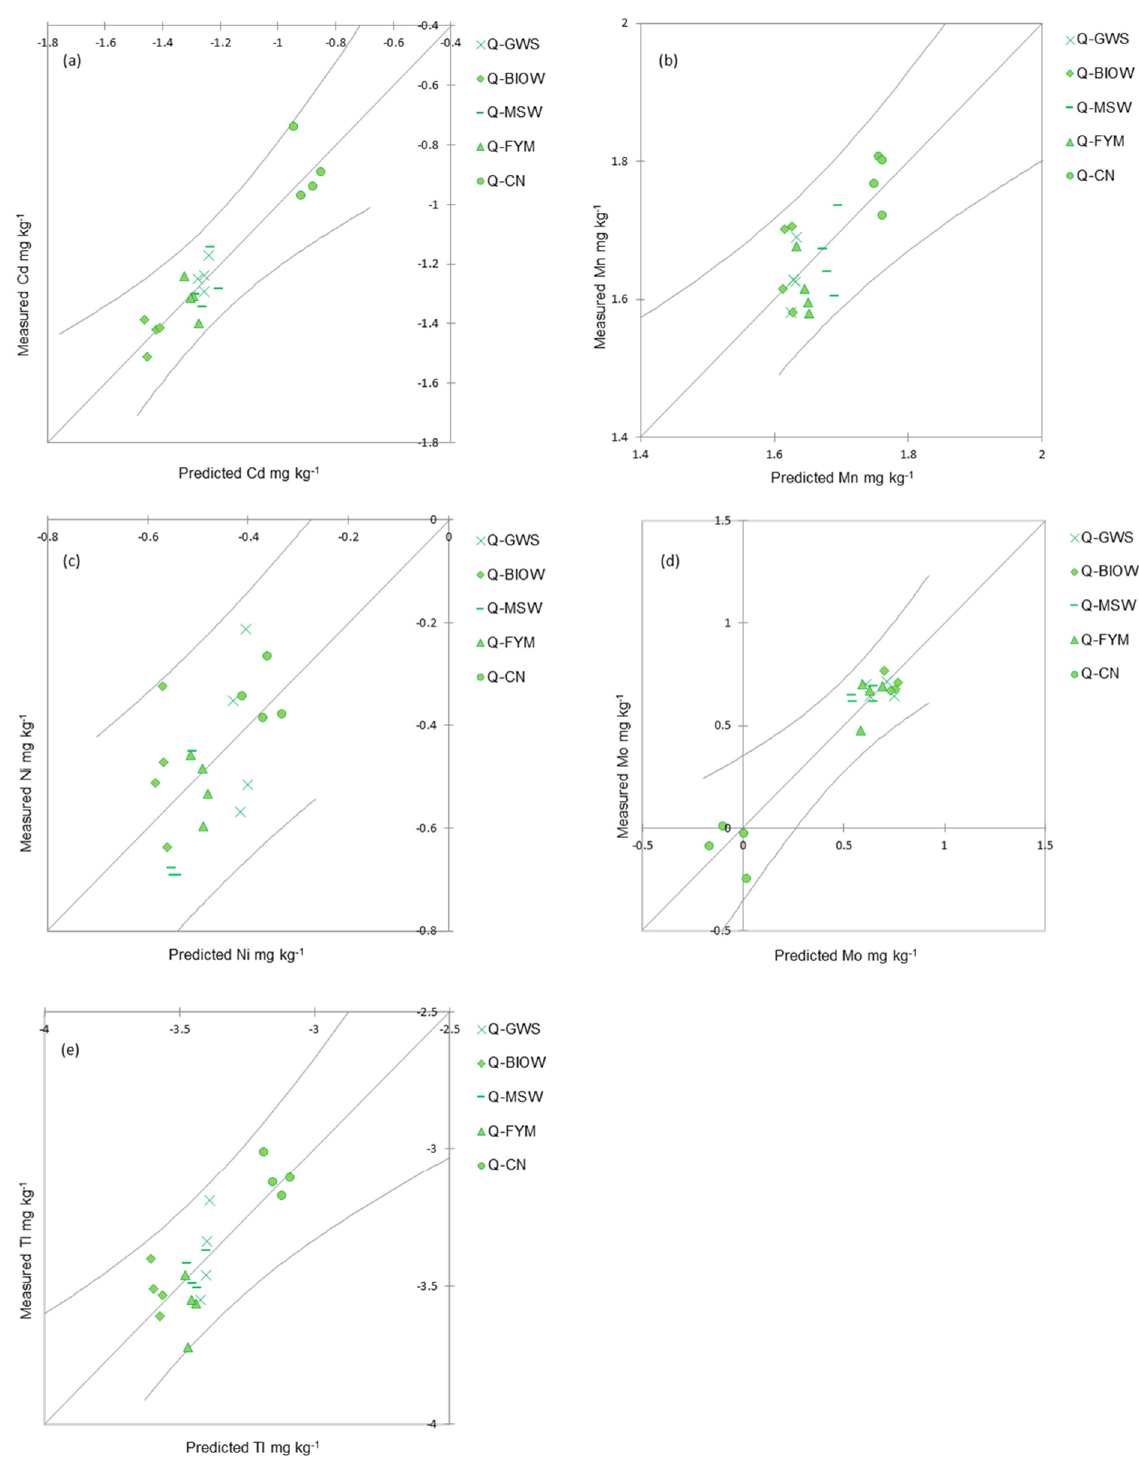
Figure 6. Multiple log–log linear regression studies for trace elements (TEs) measured in plantlets at QualiAgro site, for Cd ( a ), Mn ( b ), Mo ( c ), Ni ( d ) and Tl ( e ), with the following data presented: number of values = 44, with lower and upper bounds (95%). See Figure 1 for treatments signification.